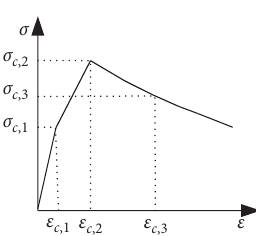
Figure 6: Schematic diagram of mechanical properties of rein- forced concrete materials under axial compression.